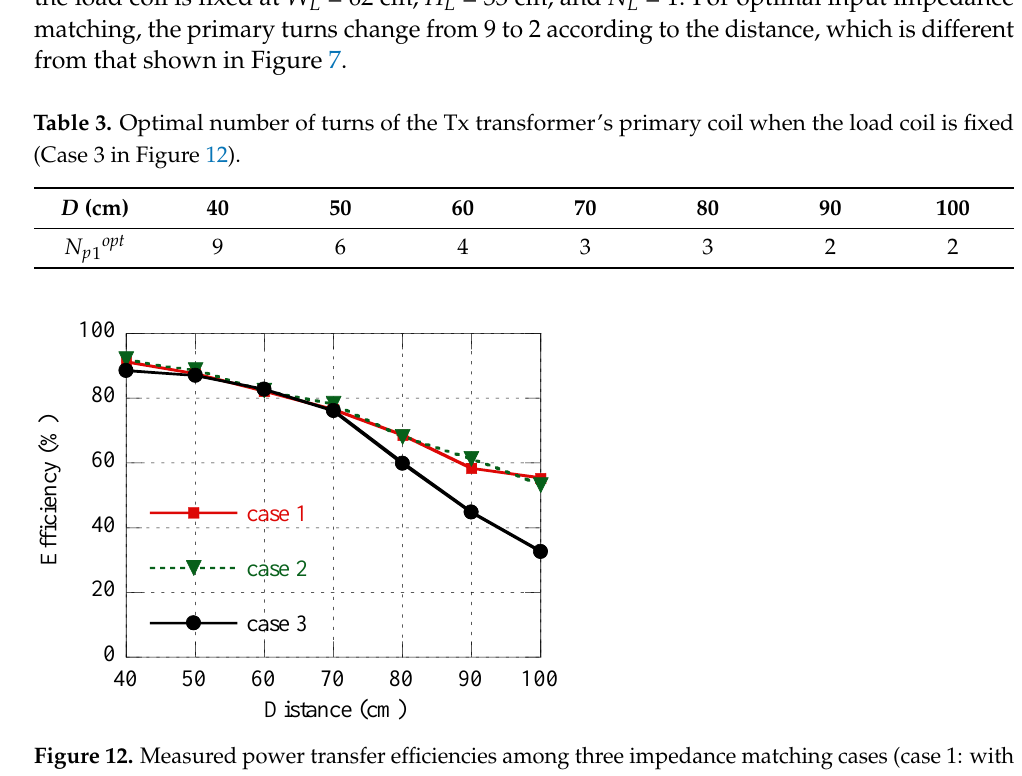
Table 2. Design parameters of the rectangular load coil for optimal load impedance matching in Figure 11.